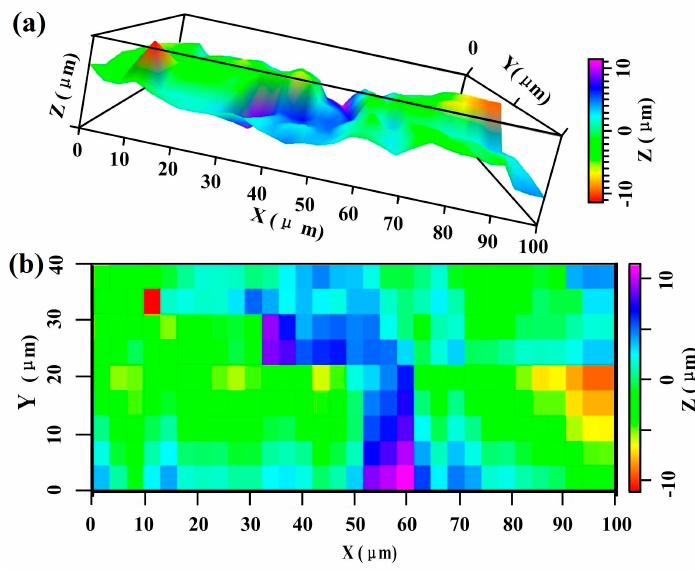
Figure 4. Surface morphology of single cutting fiber: ( a ) surface profile; ( b ) surface contour nephogram.